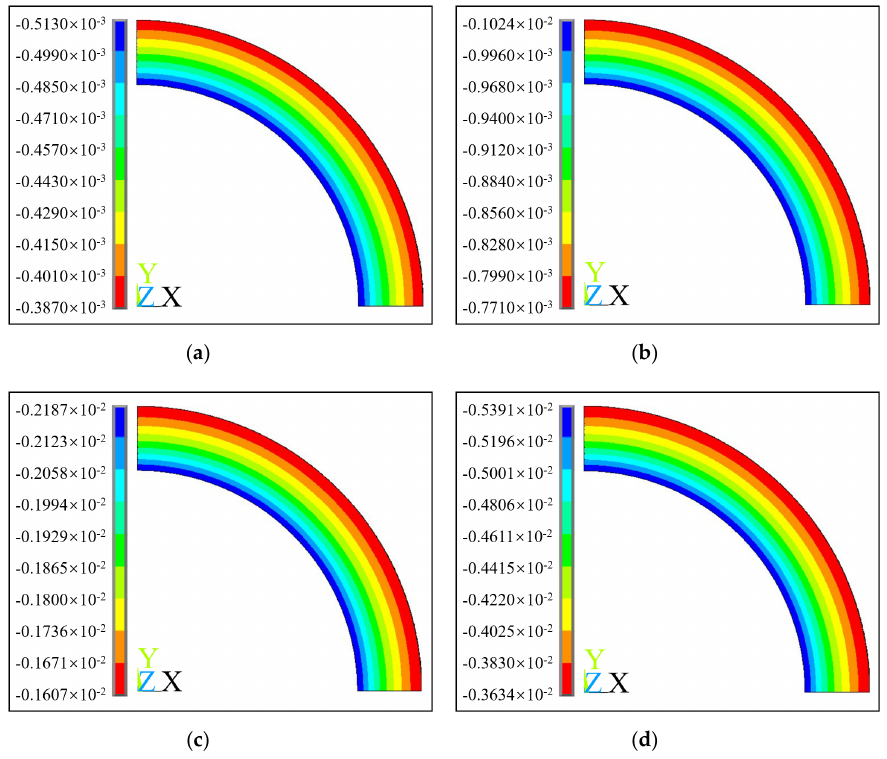
Figure 8. Hoop strain cloud diagrams of D-5 model shaft lining concrete under a surface load: ( a ) 5 MPa; ( b ) 10 MPa; ( c ) 18 MPa; ( d ) 23.3 MPa.